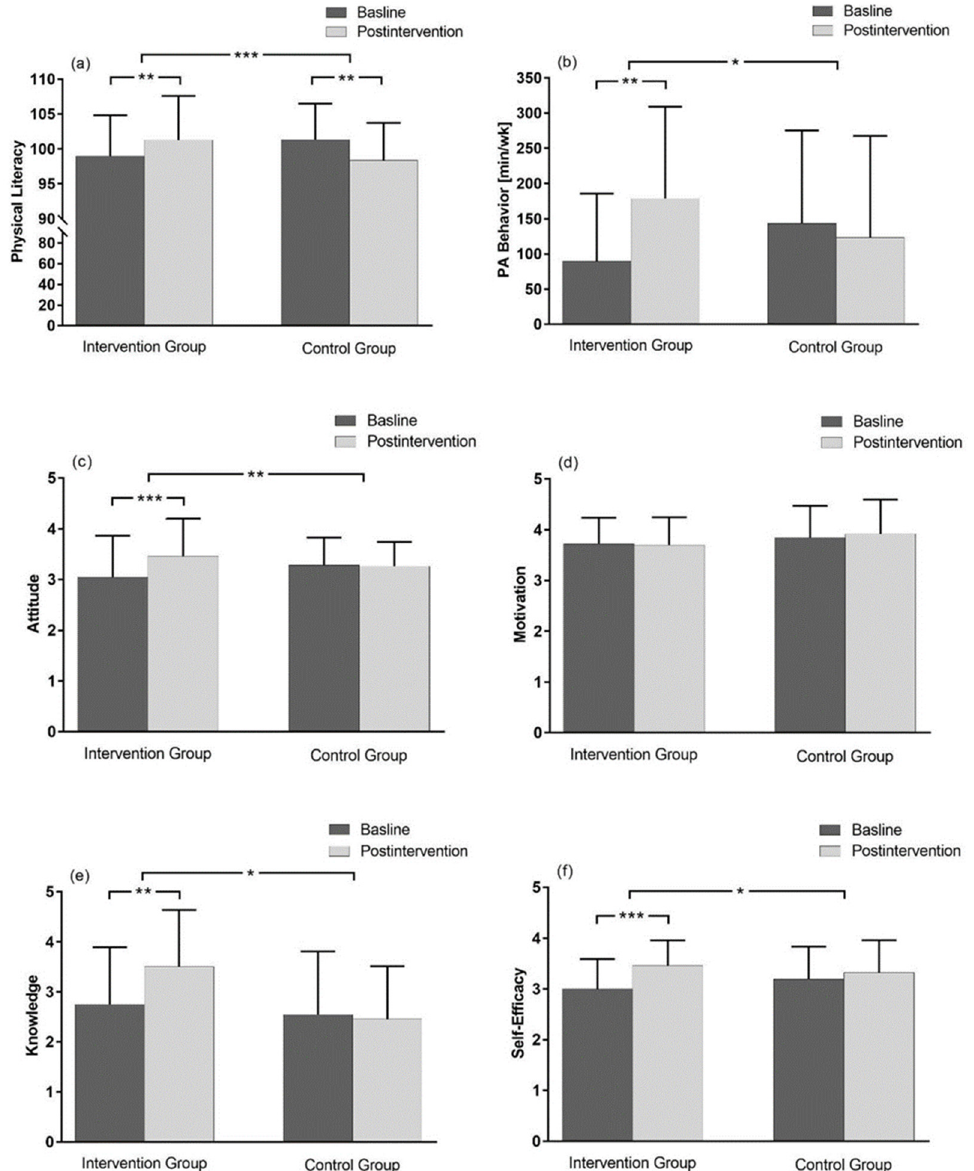
Figure 2. Physical literacy and all five domains of physical literacy by time and condition; ( a ): physical literacy, ( b ): physical activity behavior domain, ( c ): attitude/understanding domain, ( d ): motivation domain, ( e ): knowledge domain, ( f ): self-efficacy/confidence domain; Baseline: charcoal gray; postintervention: light gray; IG: intervention group; CG: control group. Values are given as mean ± SD; * p < 0.05; ** p < 0.01; *** p < 0.001.